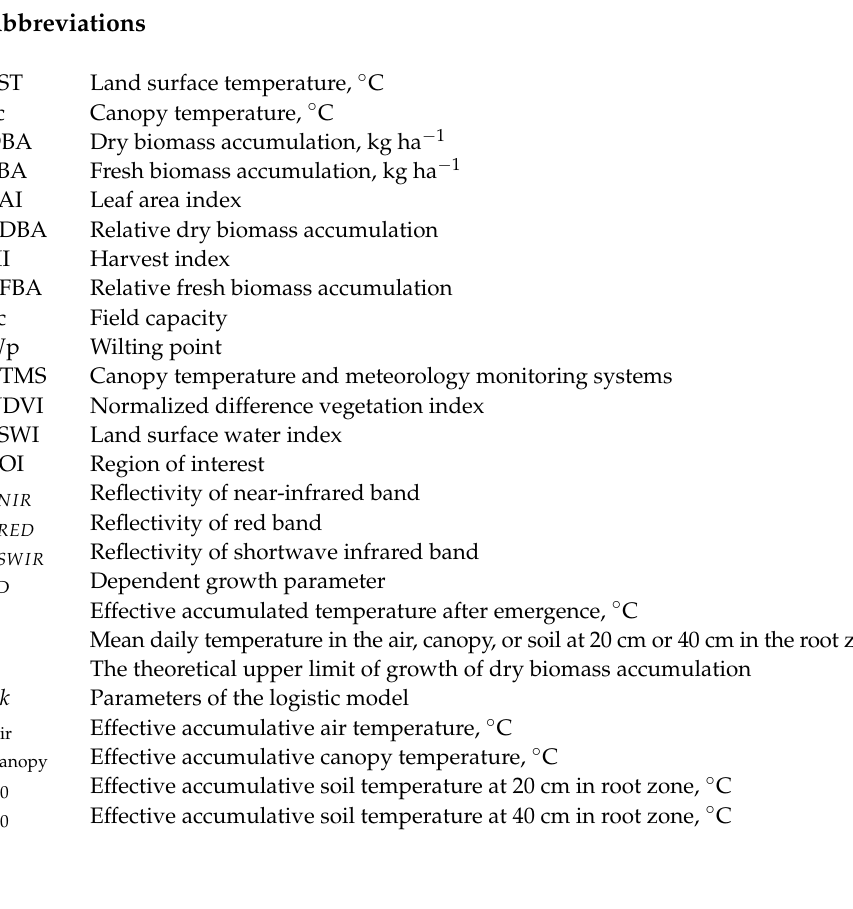
Figure S3: Regressions between the LST from MOD11A1 product and the observed Tc in field in 2017. ( a ) H4; ( b ) H5; Figure S4: Regressions between the T LST calculated by the remote